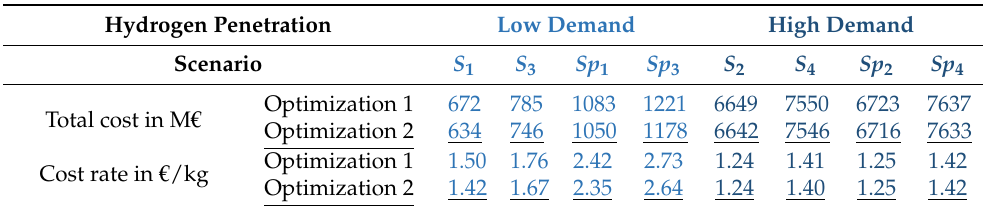
Table 7. Sensitivity analysis of the cost in M € and the corresponding cost per transported and stored hydrogen in € /kg.